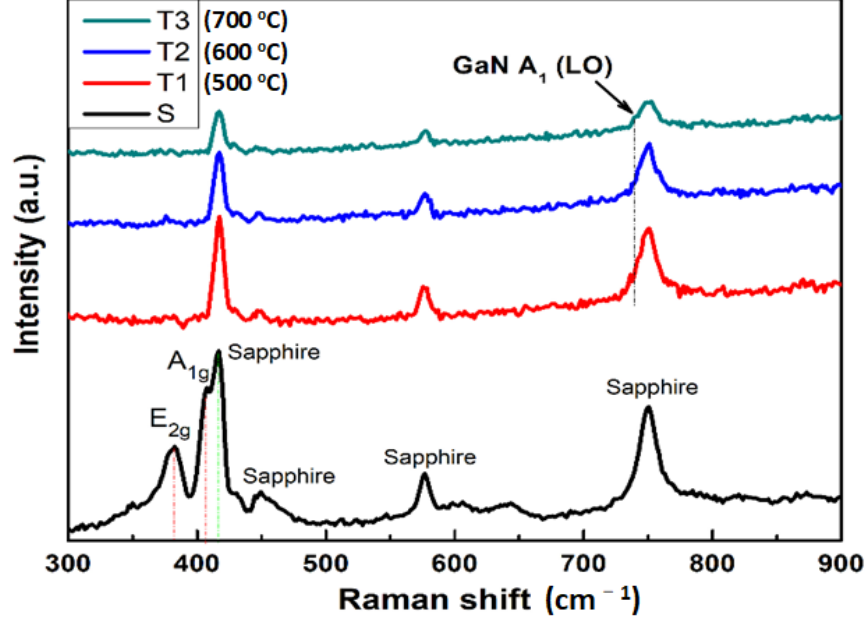
Figure 5. Raman spectra of 2D MoS 2 on c-sapphire (S) and three GaN thin films at growth temper- atures 500 °C (T1), 600 °C (T2), and 700 °C (T3). tures 500 ◦ C (T1), 600 ◦ C (T2), and 700 ◦ C